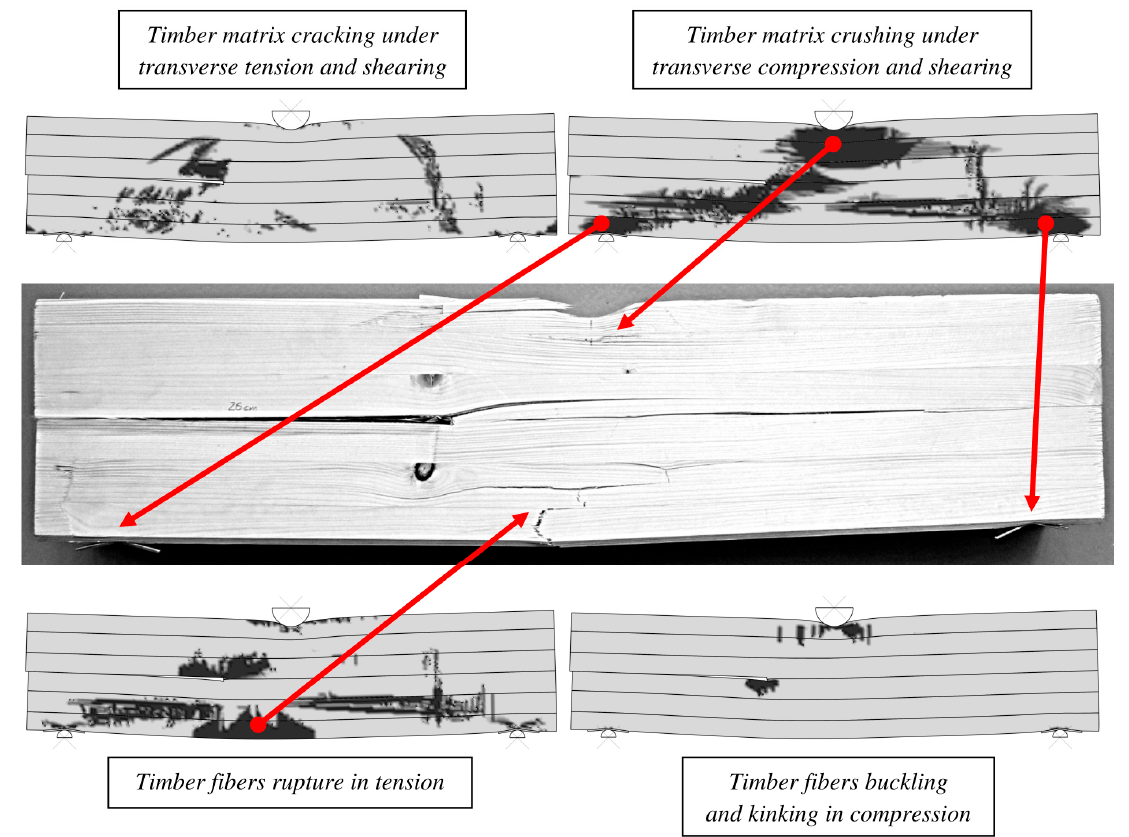
Figure 14. Timber damage identification.